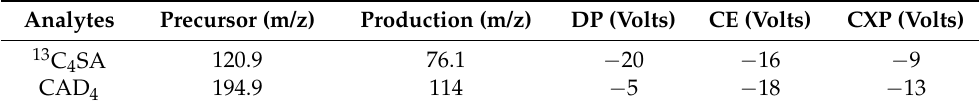
Table 1. Precursor ion, production ion, Declustering potential (DP), collision energy (CE) and collision exit potential (CXP) of 13 C 4 SA and CAD 4